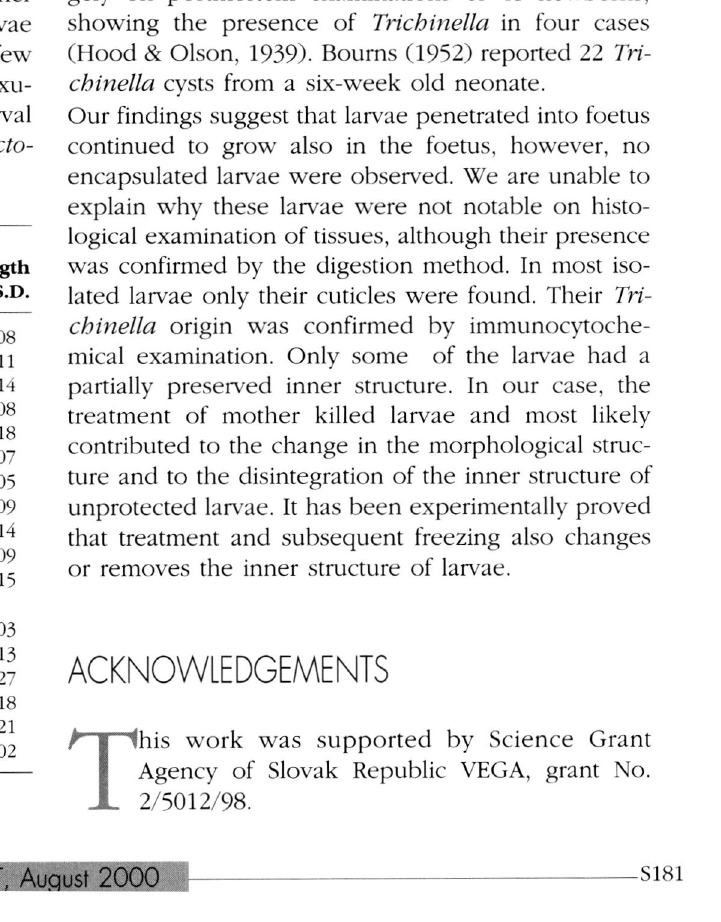
Table I. - Finding of Trichinella larvae in placenta and